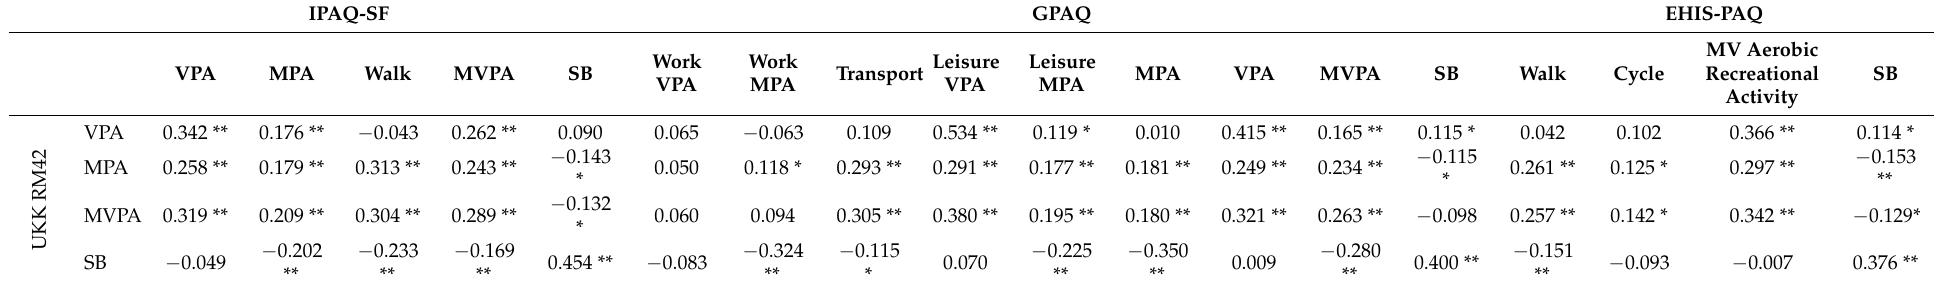
Table 4. Criterion validity of IPAQ-SF, GPAQ, and EHIS-PAQ against accelerometer UKK